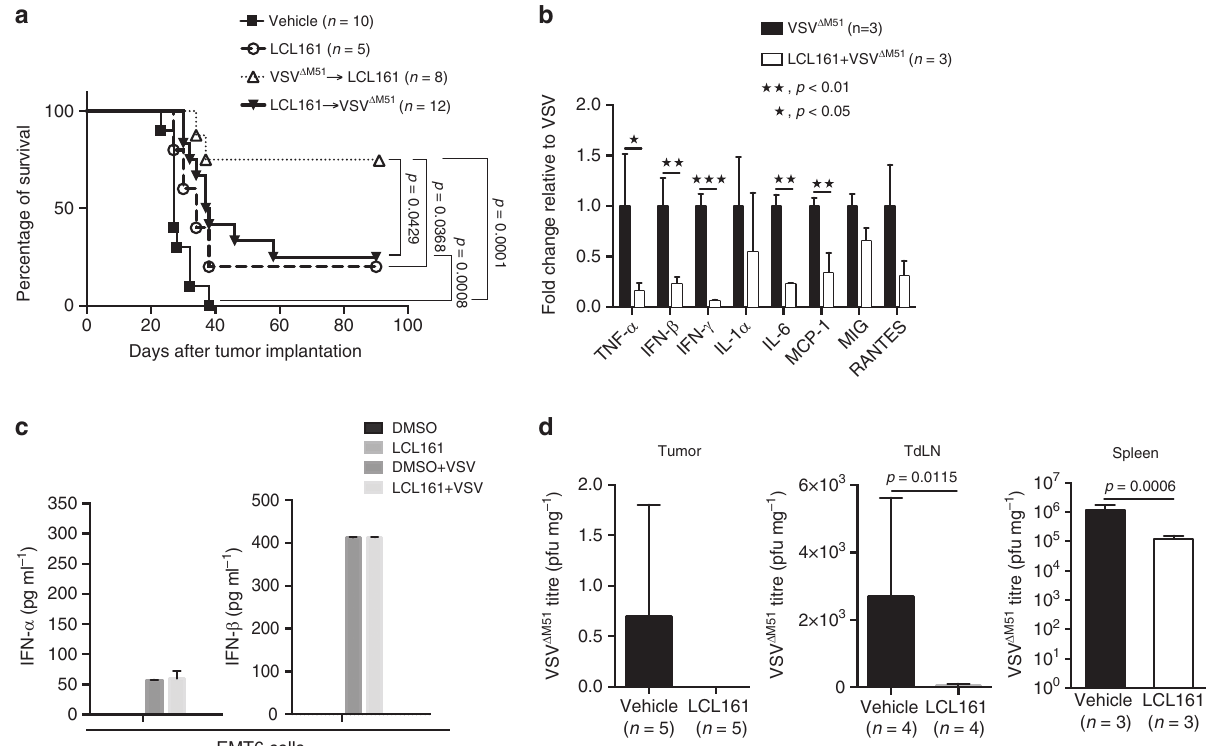
Fig. 5 Anticancer synergy between LCL161 and VSV Δ M51 is dose schedule dependent. a Overall survival of EMT6 tumor-bearing mice treated with LCL161 ± VSV Δ M51 at different dosing schedules (duplicate experiments; log-rank test). b Cytokines within blood taken from EMT6 tumor-bearing mice treated with VSV Δ M51 for 24 h, after 72 h pretreatment with LCL161 (or vehicle), measured by Luminex (single experiment; mean ± SD; t -test). c Concentration of type I IFN within EMT6 cell culture media 24 h after VSV Δ M51 ± LCL161 pretreatment for 2 h, measured by ELISA ( n = 3 biological replicates per experiment; duplicate experiments; mean ± SD). d Infectious VSV Δ M51 particles isolated from tumor, TdLN, and spleen of EMT6 tumor-bearing mice 12 h after VSV Δ M51 treatment ± LCL161 pretreatment for 72 h, measured by plaque assay (spleen, duplicate experiments; tumor and TdLN, single experiment; mean ± SD; t